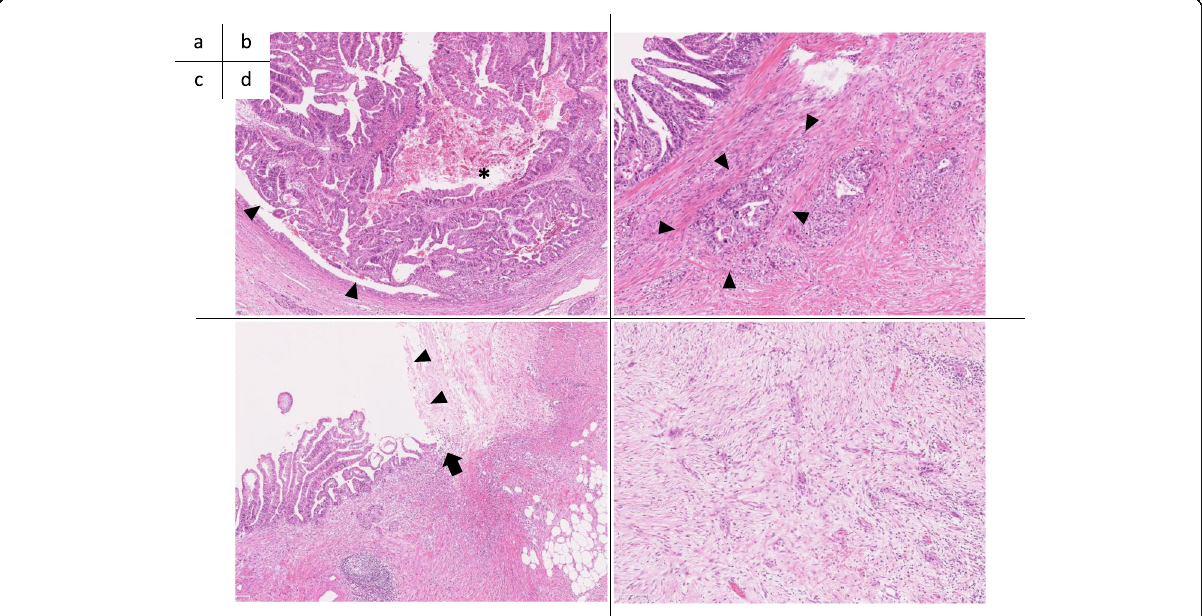
Fig. 4 Microscopic findings. a Microscopic findings of the tumor in the main pancreatic duct (MPD). The tumor showed a tubulopapillary growth pattern (arrowhead), and necrosis was observed (asterisk) (hematoxylin and eosin [H&E]; original magnification, × 50). b The tumor had invaded the stroma around the MPD (arrowhead) (H&E; original magnification, ×100). c The pancreatic duct was ruptured at the tail side of the tumor (arrow), and the fistula connected the MPD and the extrapancreatic scar tissue (arrowhead) (H&E; original magnification, × 50). d Microscopic findings of the tissues outside of the pancreas. Granulation and fibrosis were observed, and cancer cells were scattered (H&E; original magnification, ×